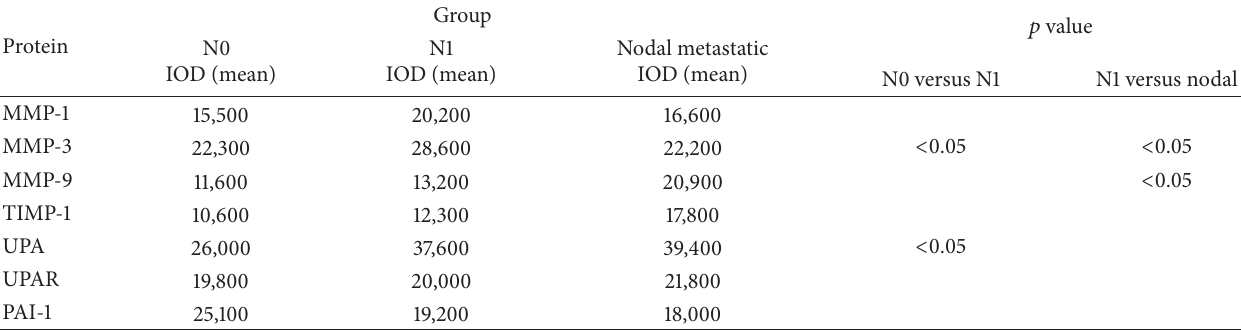
Table 2: Semiquantitation of protein samples analyzed in patients with ductal breast